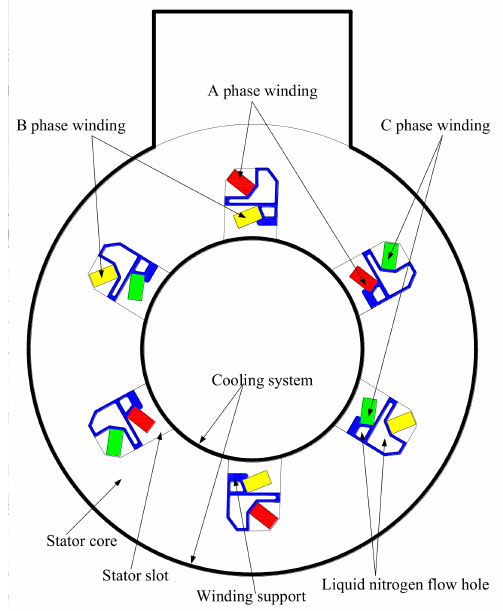
Figure 7. The fundamental structure of the proposed HTS motor